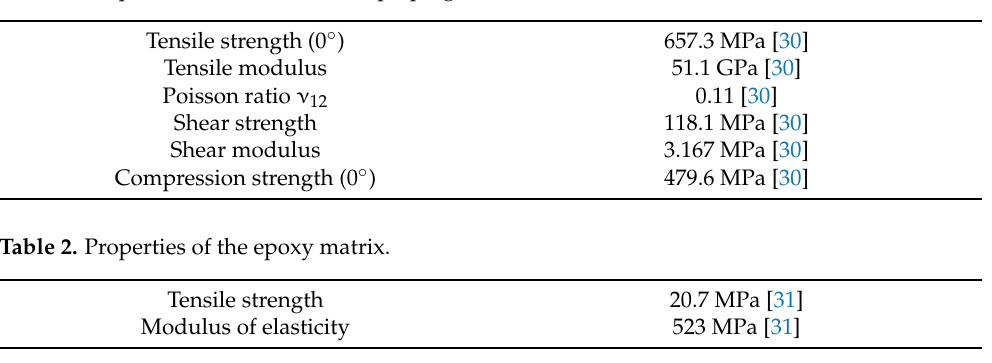
Table 1. Properties of the Kordcarbon prepreg.